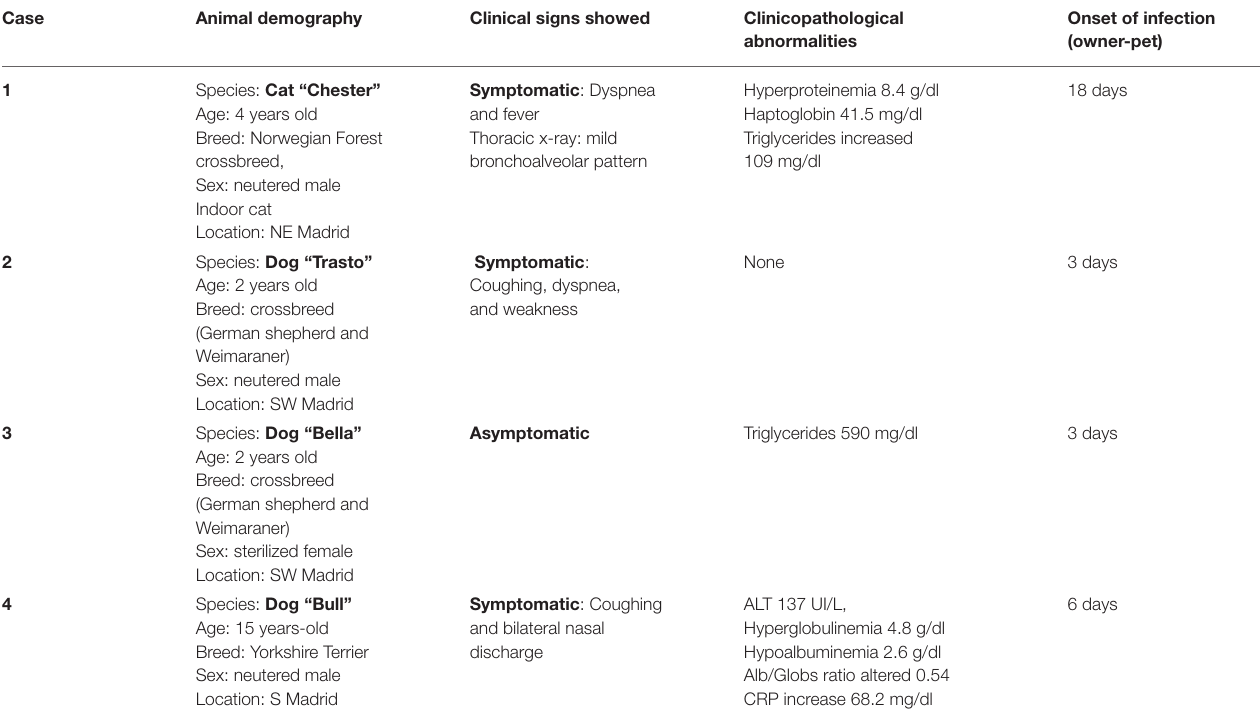
TABLE 1 | Animal demography and clinical findings of one cat and three dogs with SARS-CoV-2 infection.